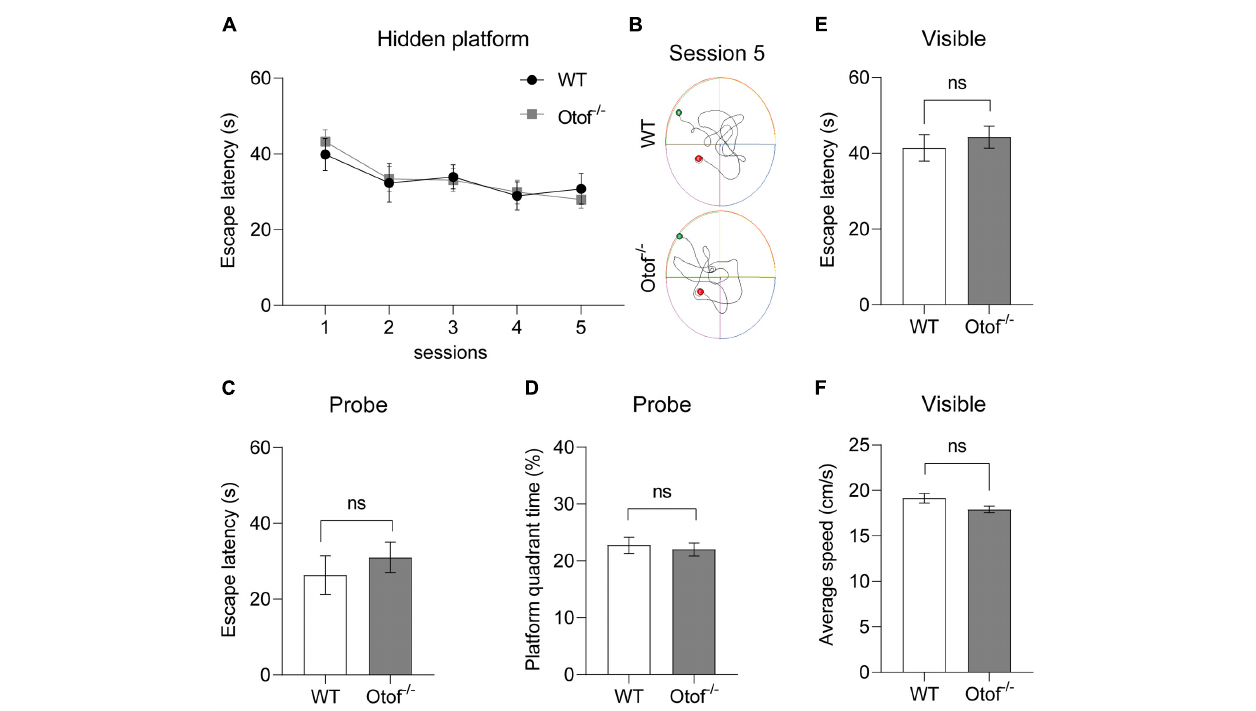
FIGURE 5 | Otof − / − mice showed normal spatial learning and memory in the Morris water maze (MWM). (A) The escape latency (time to find the hidden platform) recorded in training sessions. (B) Representative swimming trace of WT and Otof − / − mice in session 5. (C) The escape latency (s) in the probe. (D) The percent time (%) in the platform quadrant in the probe. (E) The escape latency (s) in the visible platform period. (F) The average swimming speed (cm/s) in the visible platform period. All values are presented as mean ± SEM and analyzed by unpaired t -test for (C–F) and two-way ANOVA for panel (A) vs. WT. WT: n = 12; Otof − / − : n = 17. WT, wild-type mice; Otof − / − , otoferlin knockout mice; ns, not